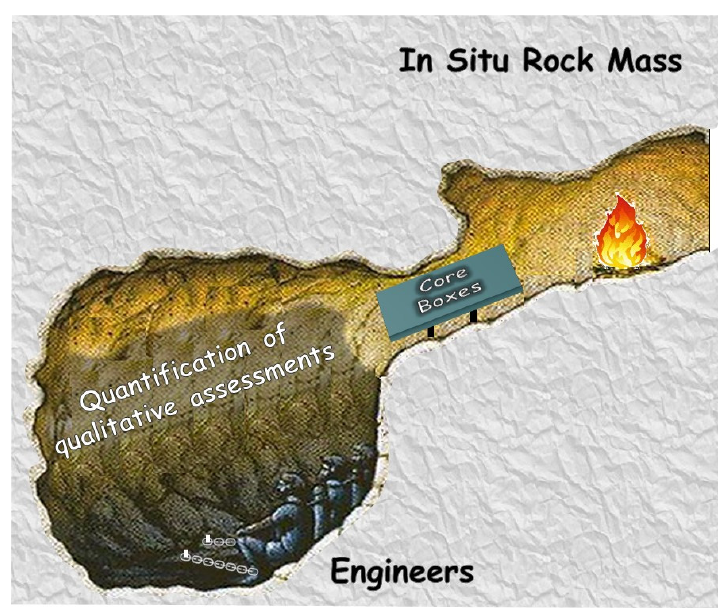
Figure 2. The allegory of the rock engineering cave.